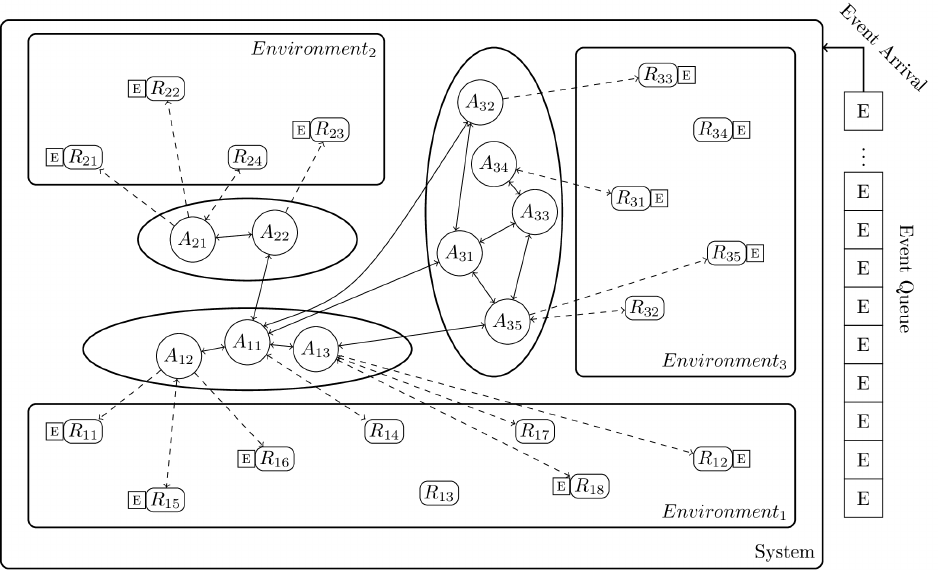
Figure 2. Scenario for resources being modified by external events while agents manage